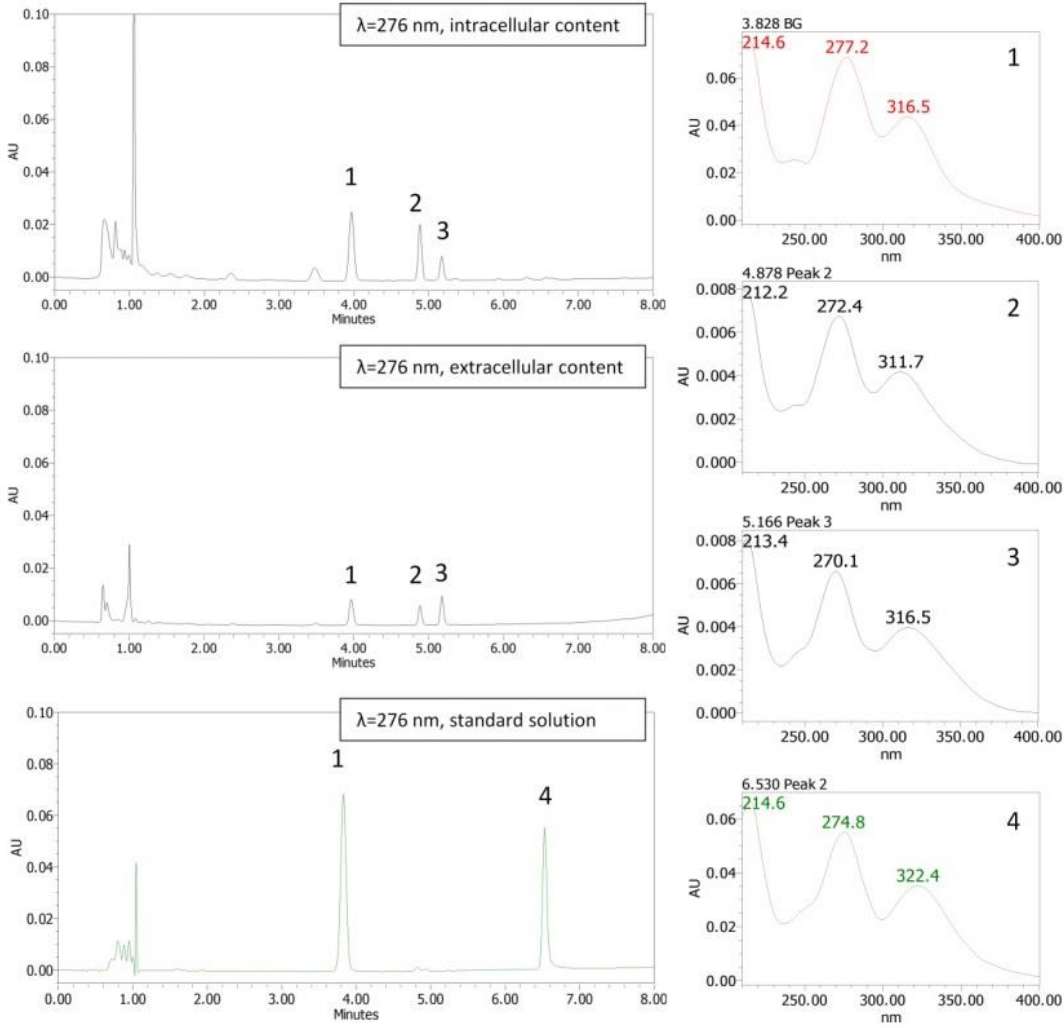
Figure 9 . HPLC chromatographic analysis of compounds detected in HT – 29 cells after 3 h of incubation of 5 µM baicalein. Chromatograms of the intracellular, extracellular, and standard contents are reported. The panels on the right show the UV spectra of the peaks revealed during the analysis. Peak 1 has been identified as baicalein-7-glucuronide (baicalin), while peaks 2 and 3 are unknown metabolites. Standard baicalein peak 4, Rt 6.53 min; baicalin standard, peak 1, Rt 3.83 min.